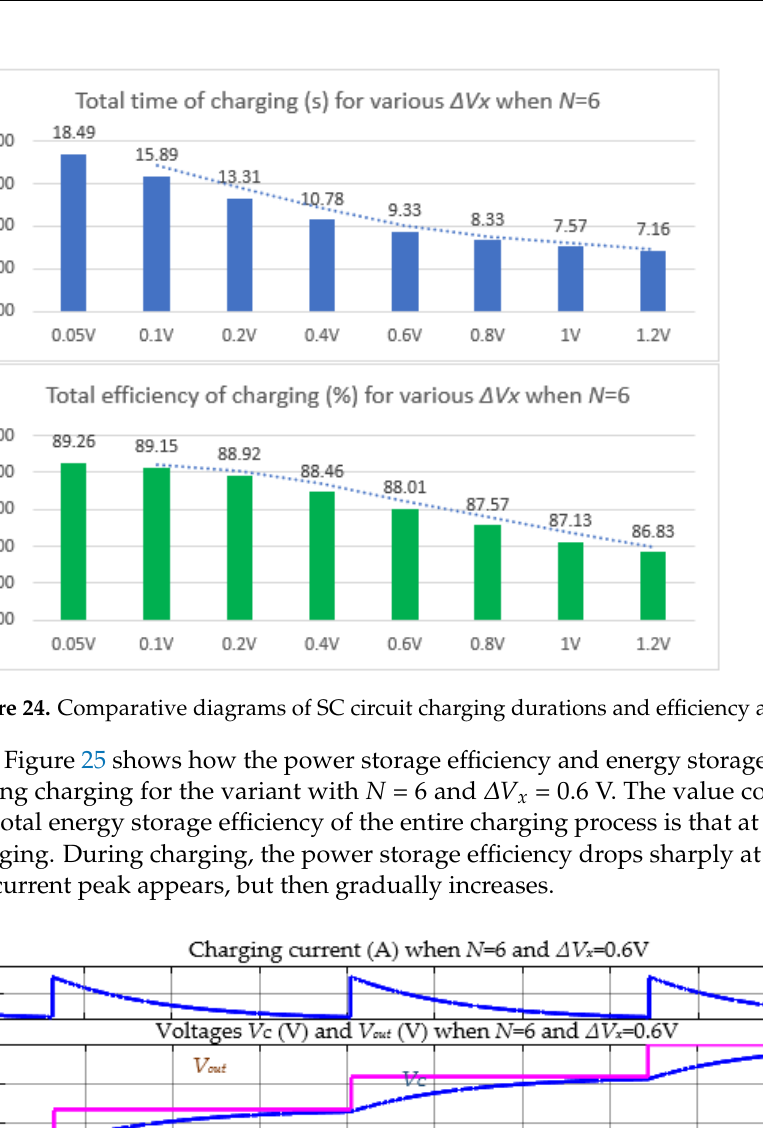
Figure 23. SC circuit charging current and voltage curves in the case of six phases at different ∆ V x.